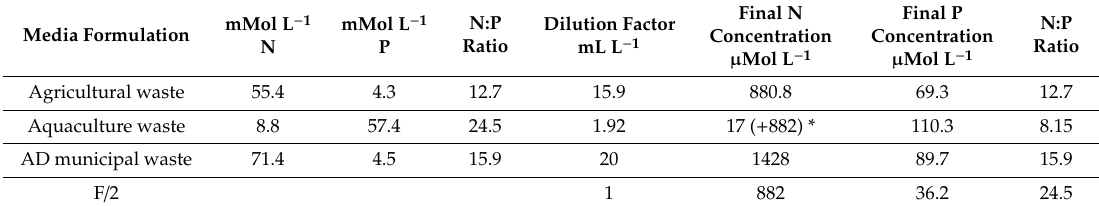
Table 1. Nutrient concentrations of selected waste-based media before and after